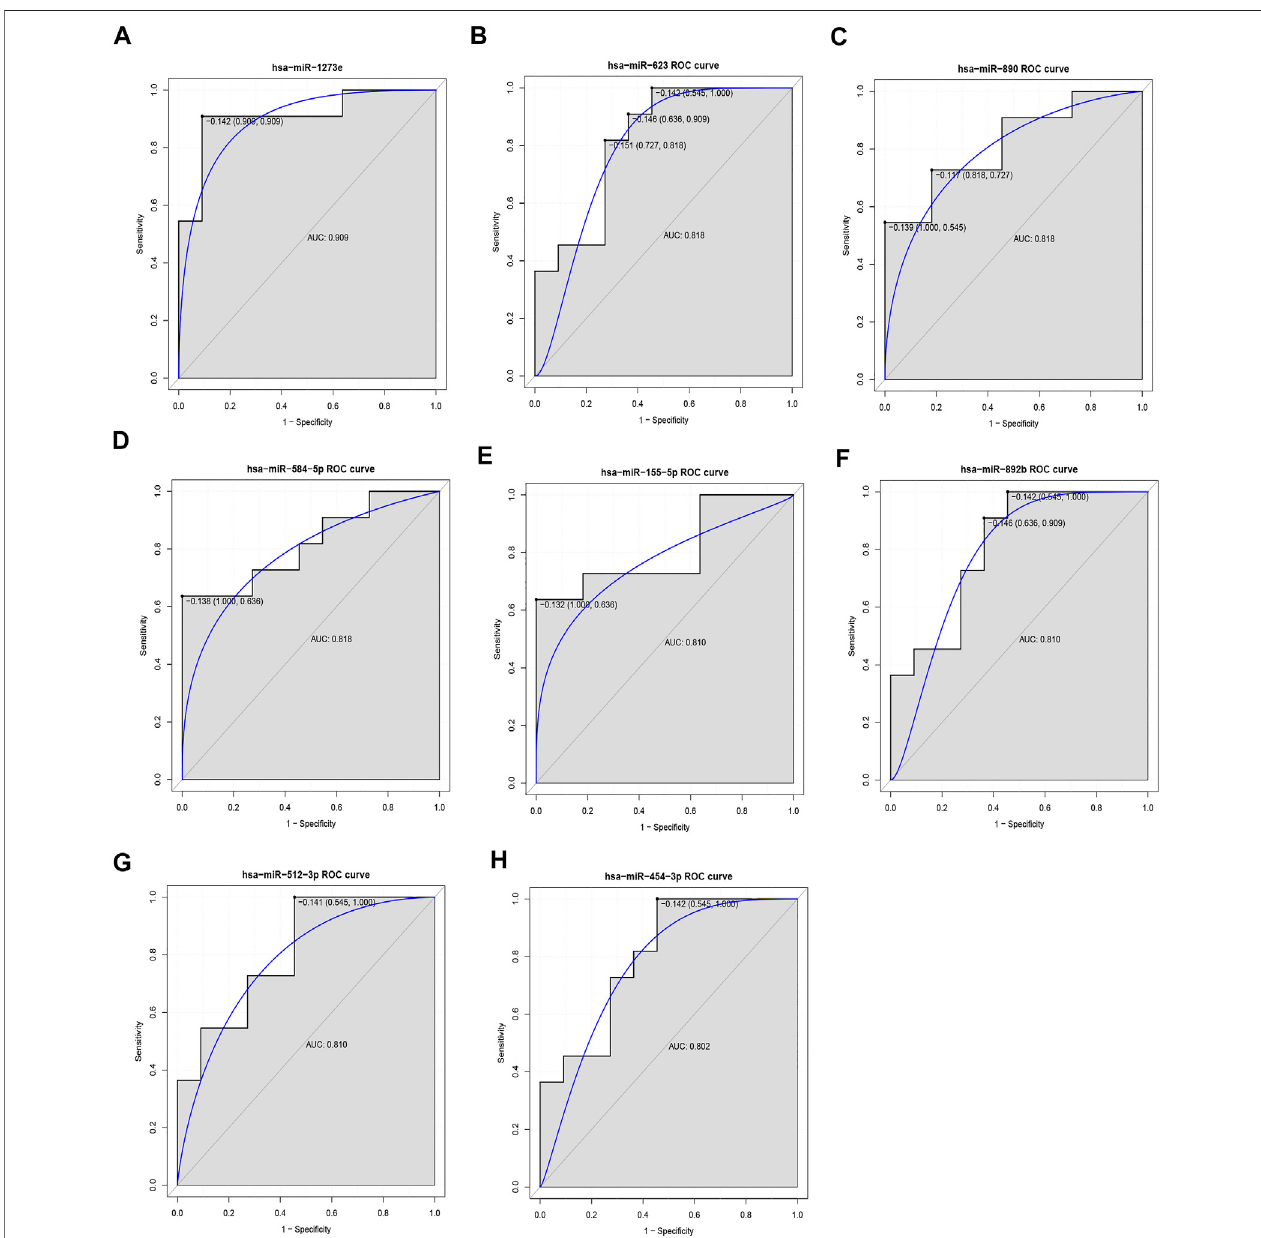
FIGURE 7 | ROC analysis of down-regulated DEMis in IDD. (A) ROC analysis of miR-1273e, (B) ROC analysis of miR-623, (C) ROC analysis of miR-890, (D) ROC analysisofmiR-584-5p, (E) ROCanalysisofmiR-155-5p, (F) ROCanalysisofmiR-892b, (G) ROCanalysisofmiR-512-3p,and (H) ROCanalysisofmiR-454-3p.DEMis: differentially expressed microRNAs; IDD: intervertebral disc degeneration; and ROC: receiver operating